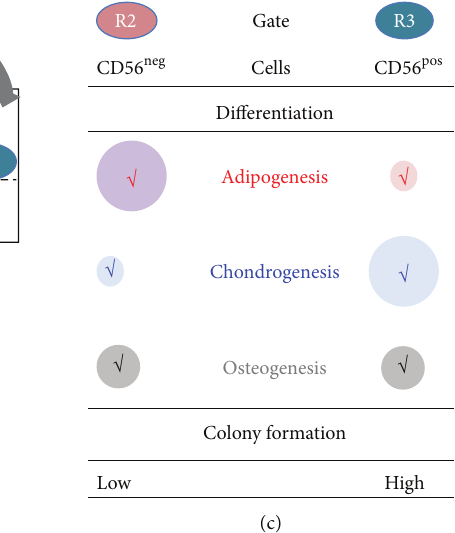
Figure 4: Schematic draft of the experimental strategy to define and functionally characterize subsets of human bmMSCs. MSCs were sorted by fluorescence-activated cell sorting (FACS) (left panel). From the mononuclear cells the CD271+ subset, which is gated in R1, was further subdivided by staining with two additional antibodies to TNAP and CD56 positive cells (gates R2 and R3, middle panel). The populations defined by R2 or R3 were expanded in separate cultures and their proliferation and differentiation were compared (right panel) (for further details see